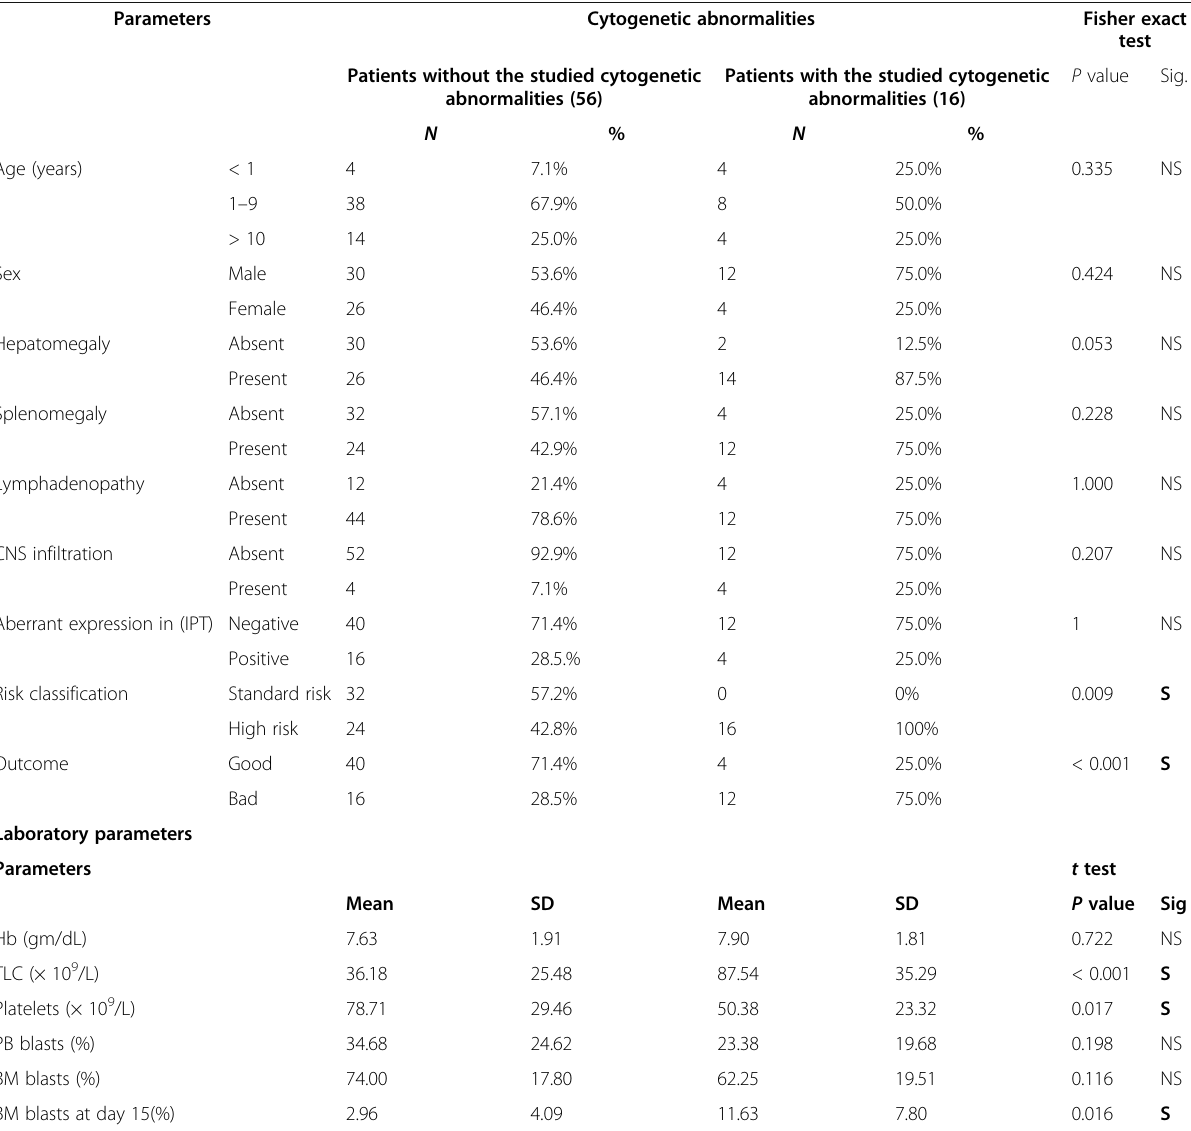
Table 3 Comparative analysis between patients ’ groups with and without studied cytogenetic abnormalities regarding different